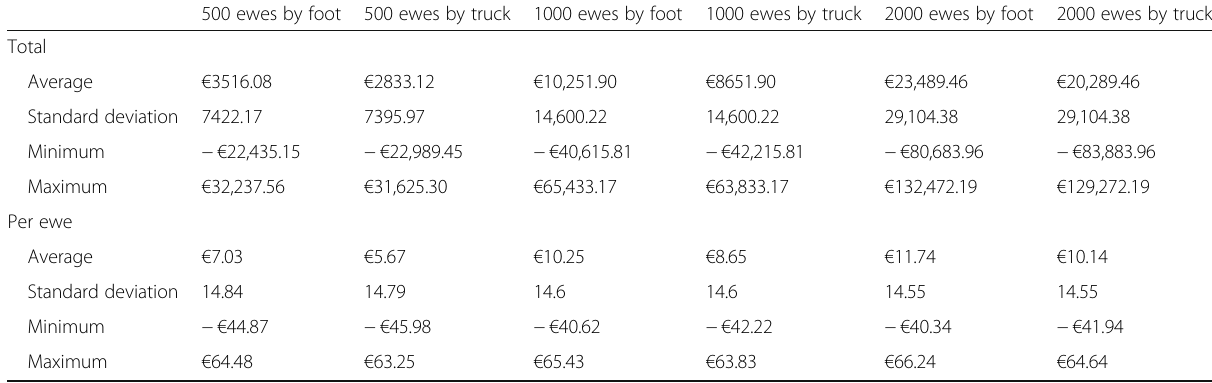
Table 6 Comparison of relative profitability of transhumant compared to semi-extensive operations based on triangular distributions with parameter estimates in Table